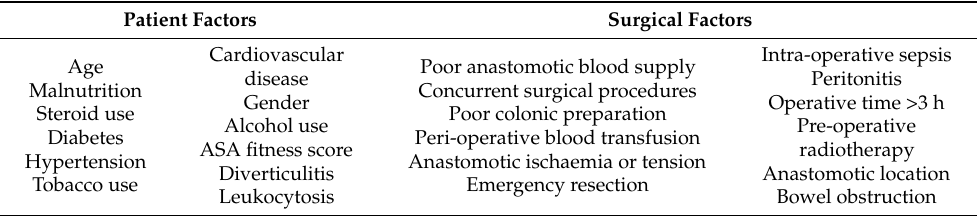
Table 1. Risk factors associated with the development of an anastomotic